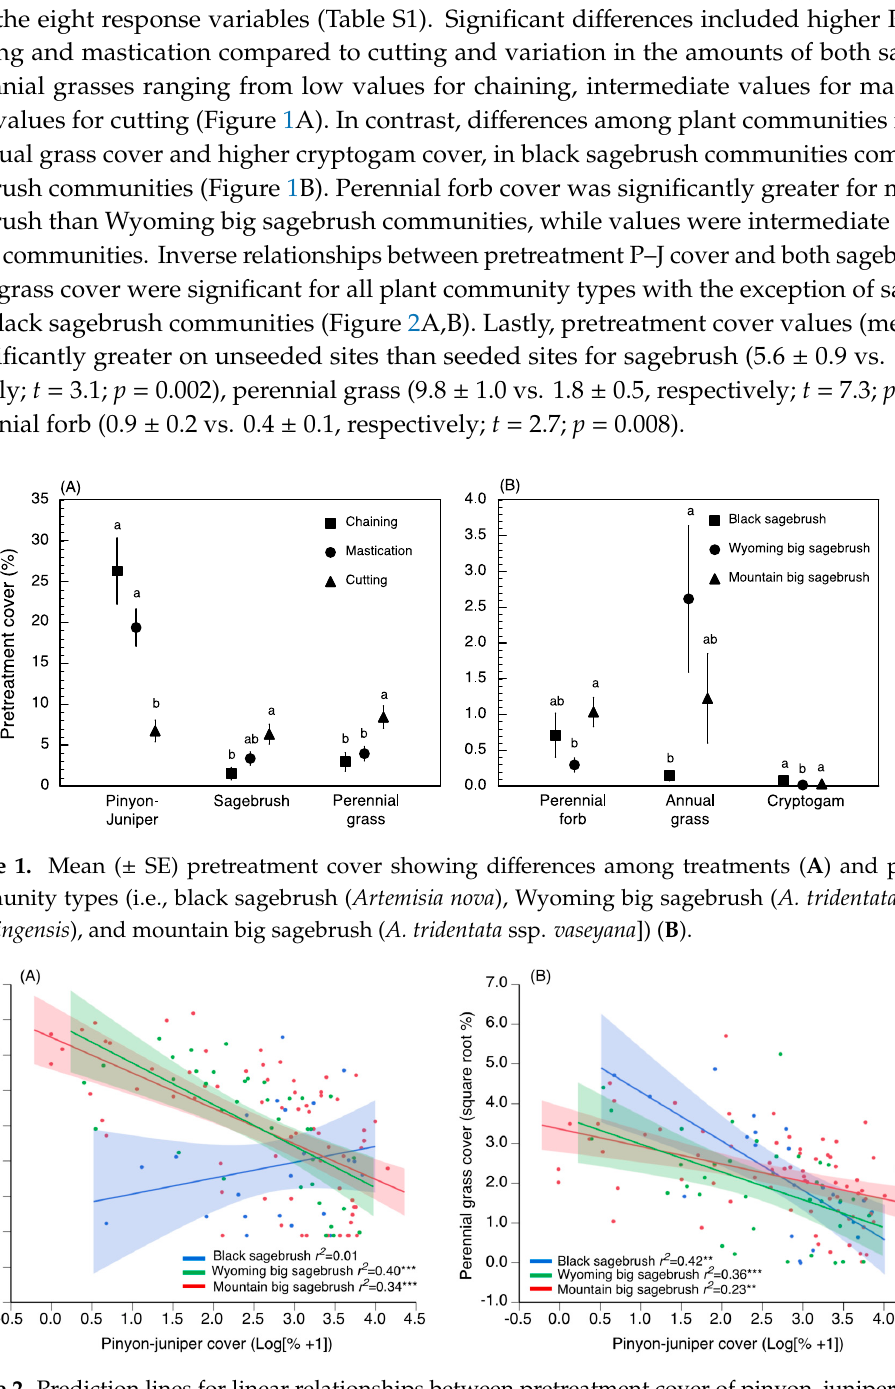
Figure 2. Prediction lines for linear relationships between pretreatment cover of pinyon–juniper and sagebrush ( A ) and between pinyon–juniper and perennial grass ( B ) in three sagebrush community types (i.e., black sagebrush ( Artemisia nova ; n = 43), Wyoming big sagebrush ( A. tridentata ssp. wyomingensis ; n = 63), and mountain big sagebrush ( A. tridentata ssp. vaseyana ; n = 128). Shaded regions are 95% confidence intervals. Asterisks indicate significance (*** p < 0.001, ** p < 0.01).